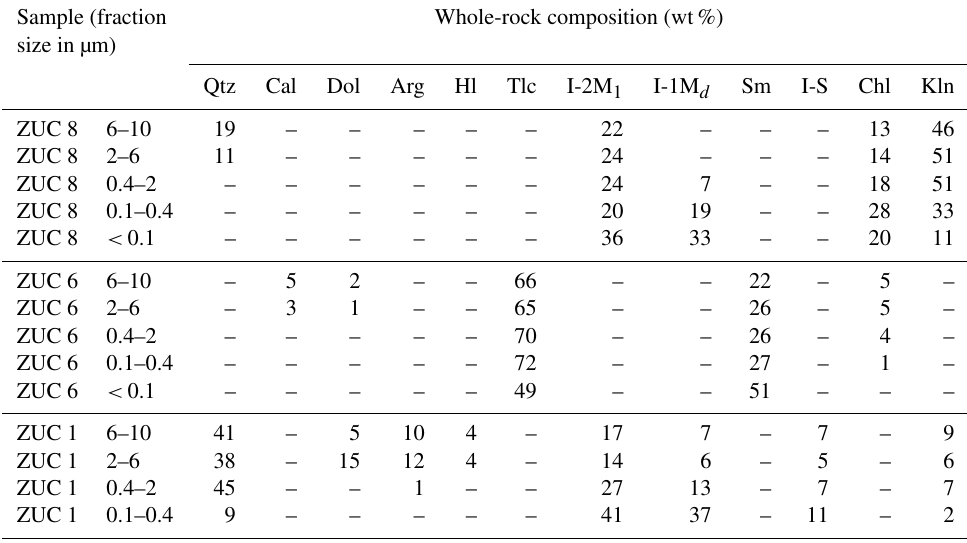
Table 2. Mineralogical composition of various grain size fractions for gouges of the ZF. Qtz stands for quartz, Cal stands for calcite, Dol stands for dolomite, Arg stands for aragonite, Hl stands for halite, Tlc stands for talc, I-2M1 stands for illite–muscovite-2M1, I-1Md stands for illite-1Md, Sm stands for smectite, I–S stands for mixed layers of illite–smectite, Chl stands for chlorite, and Kln stands for